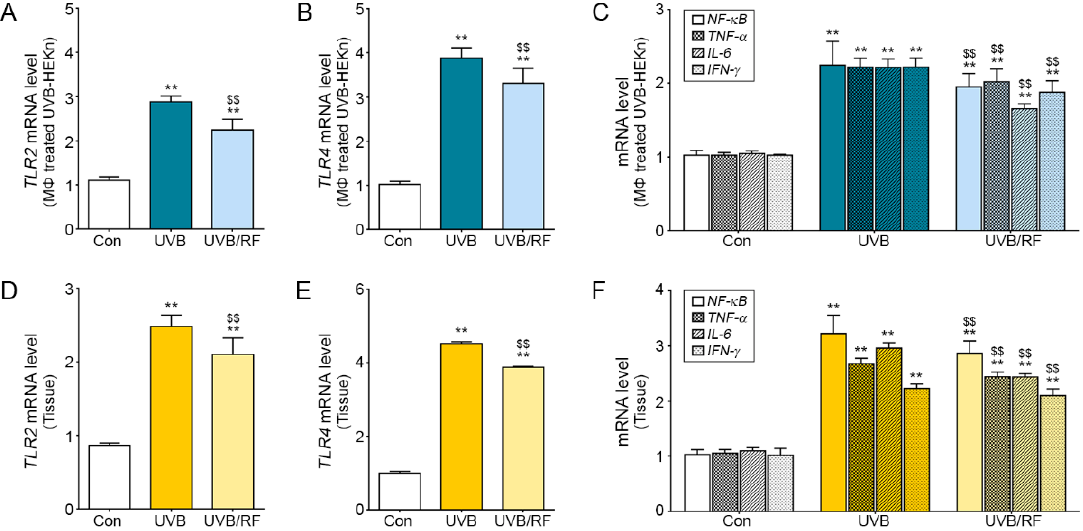
Figure 3. Inhibitory effects of RF irradiation on Toll-like receptor 2 (TLR2) and TLR4 expression in activated macrophages through keratinocyte modulation. The graphs show mRNA levels of TLR2, TLR4, and inflammation-related factors, including nuclear factor kappa-light-chain-enhancer of activated B cells (NF- κ B), necrosis factor-alpha (TNF- α ), IL-6, and interferon-gamma (IFN- γ ), measured in ( A – C ) macrophages affected by UVB-radiated keratinocytes and ( D – F ) the skin dermis of a UVB-radiated mouse. ** p < 0.01 vs. Con group; $$ p < 0.01 vs. UVB group. Results are presented as means ± standard deviations. Con, sham control; IL-6, interleukin 6; IFN- γ , interferon-gamma; mRNA, messenger RNA; NF- κ B, nuclear factor kappa-light-chain-enhancer of activated B cells; RF, radiofrequency; TLR, Toll-like receptor; TNF- α , tumor necrosis factor-alpha; UVB, ultraviolet B.